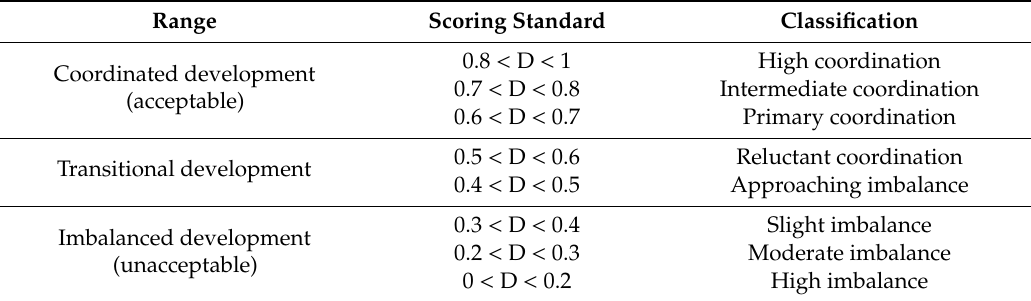
Table 2. Discriminating standard for the coupling coordination